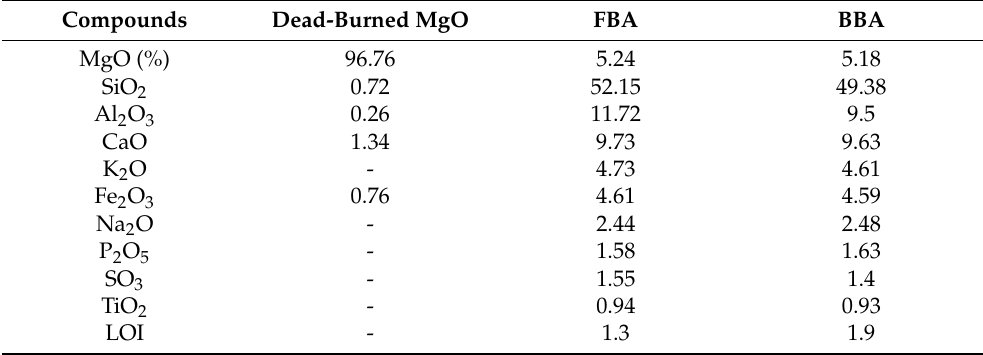
Table 1. Chemical composition of dead-burned MgO and BAs as determined by XRF.